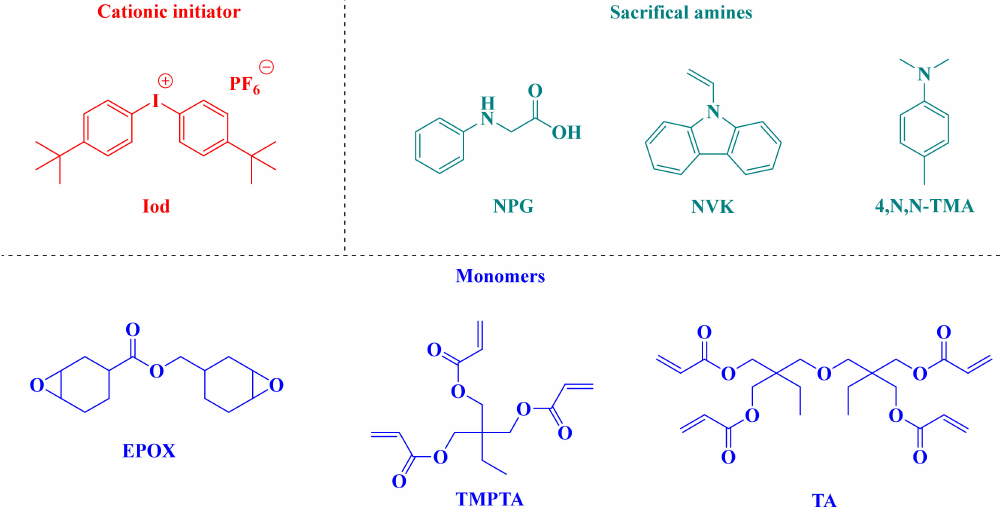
Figure 8. Other organic compounds used in this